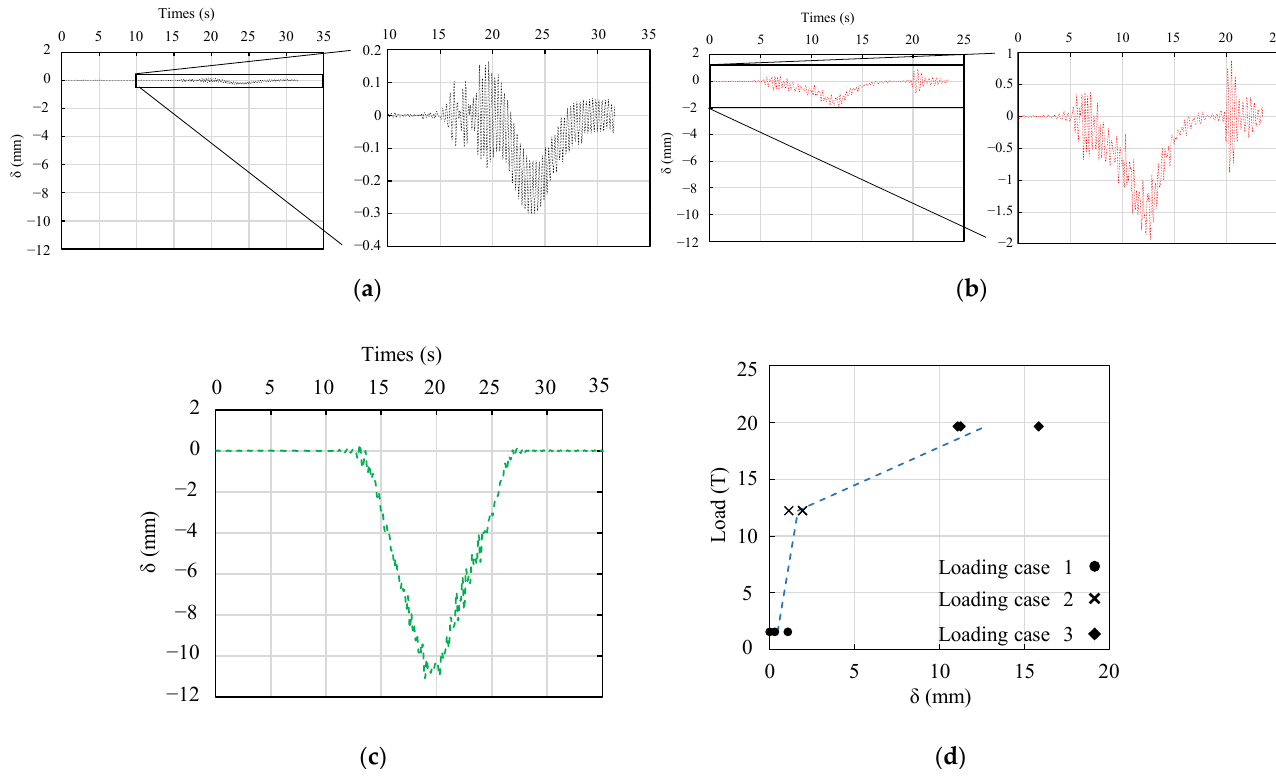
Figure 9. Dynamic Response: ( a ) Loading case 1. ( b ) Loading case 2. ( c ) Loading case 3. ( d ) Maximum deflections at each loading case.